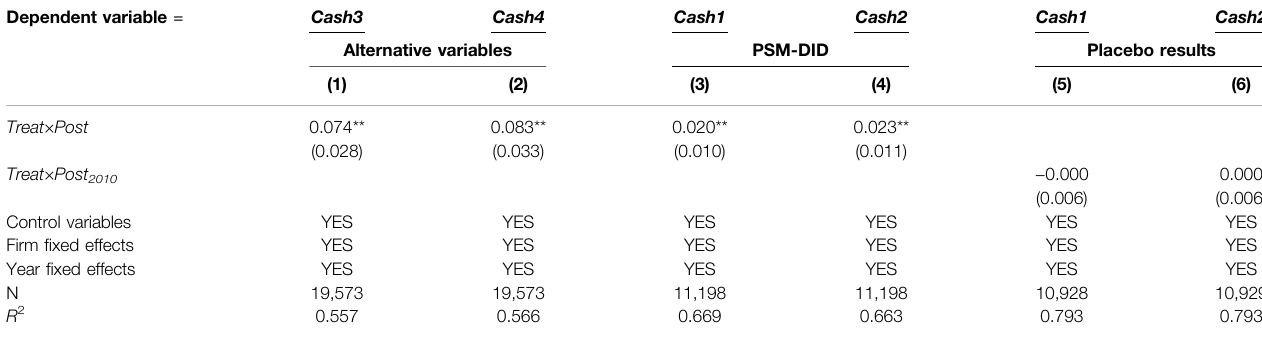
TABLE 6 | A series of robustness